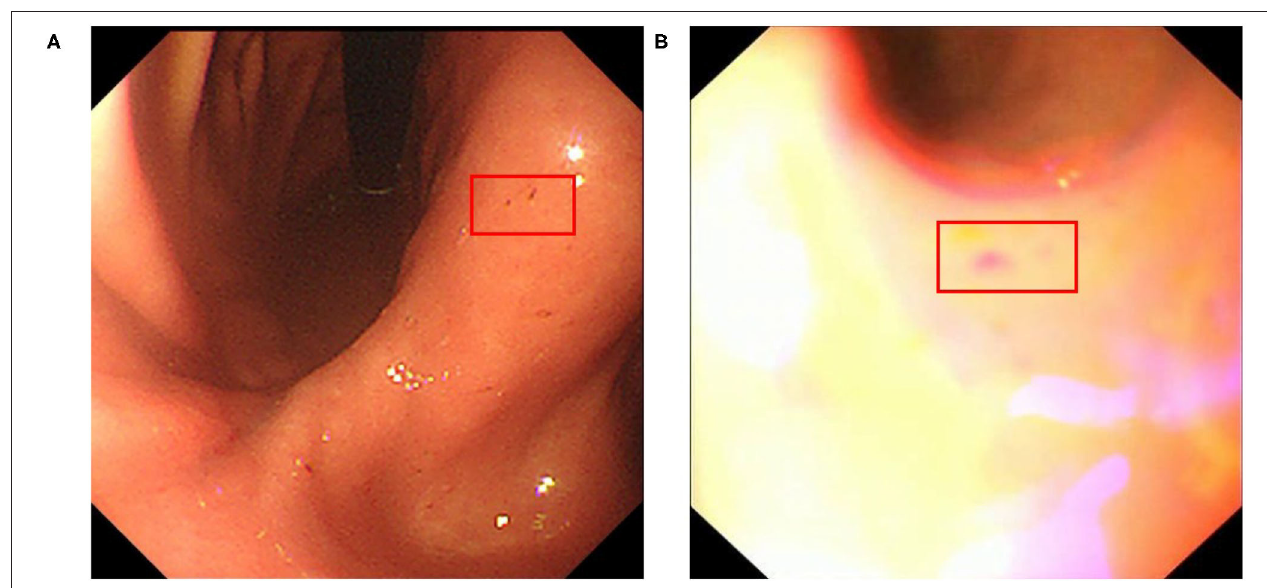
FIGURE 3 | Example erosive images from datasets (A,B) red box indicates the location of erosive lesions.